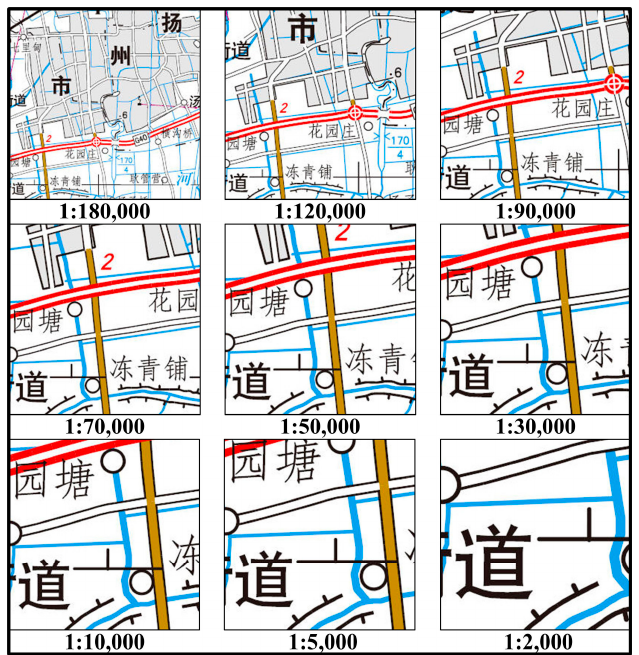
Figure 14. Single-level PDF tile infinite zooming. All ratios from “1:180,000” to “1:2,000” denote the map display ratio.